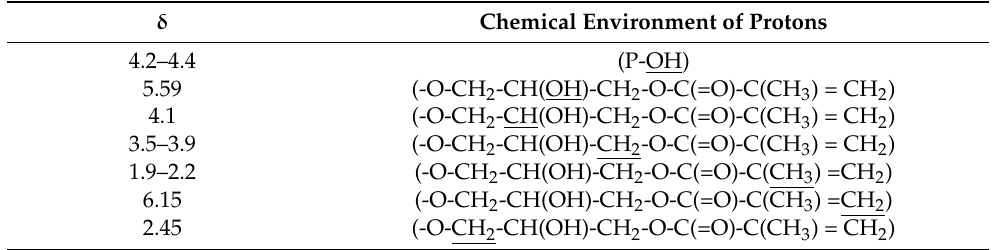
Table 1. Chemical shift values ( δ ) of various protons in product GPA.